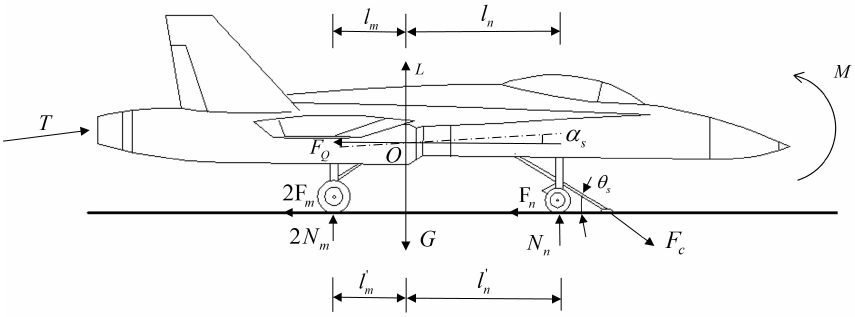
Figure 2. Force analysis of gliding aircraft after holdback bar